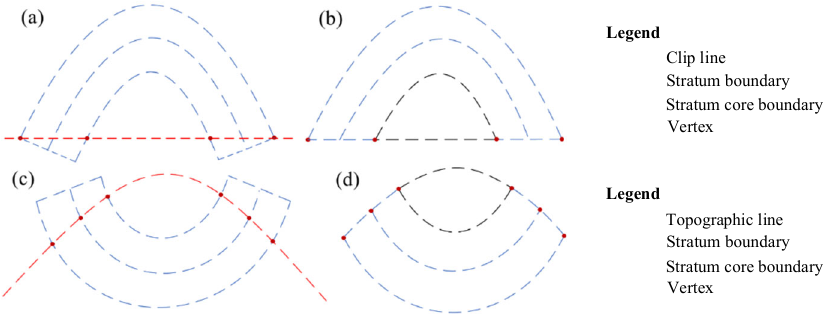
Figure 7. Trimming and optimization of the middle section, ( a ) bottom trimming line of the anti ‐ cline, ( b ) supplement the core stratum of the anticline after trimming, ( c ) topographic line at the top of the syncline, and ( d ) supplement the core stratum of the syncline after trimming.